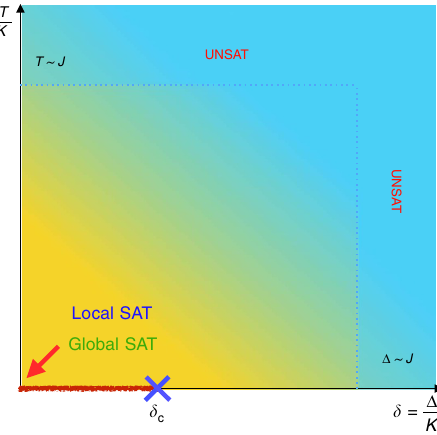
Figure 3 | Phase diagram of the vertex model. Our exact calculation of the partition function shows that there is no phase transition along the classical path ( d ¼ 0). We argue that there should be a quantum phase transition for some critical d c Moreover, along the ‘quantum’ axis T ¼ 0 the vertex model must encounter a zero-temperature quantum phase transition at a finite value of d . This follows from considering trivial classical circuits with no TOFFOLI gates in which case an L (cid:4) W vertex model is equivalent to 3 L decoupled Ising chains of size W in a transverse magnetic field. Just as in the one-dimensional Ising model in a transverse field, in the limit of no TOFFOLI gates one expects a zero-temperature second-order quantum phase transi-